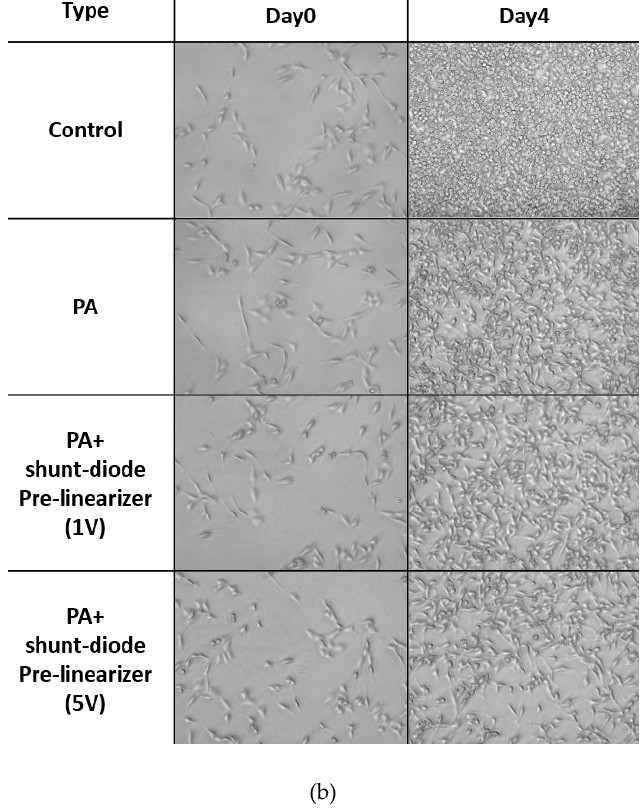
Figure 5. ( a ) Block diagram of the human cervical cancer cell (HeLa) cell experiments using the PA with and without shunt-diode pre-linearizer and ( b ) representative brightfield images of HeLa cell from Day 0 to Day 4 acquired using an inverted microscope.